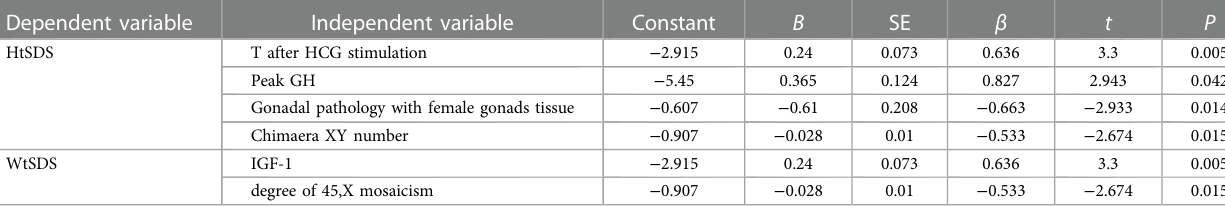
TABLE 6 Regression analysis of HtSDS, WtSDS and various indicators in 45,X/46,XY children. Dependent